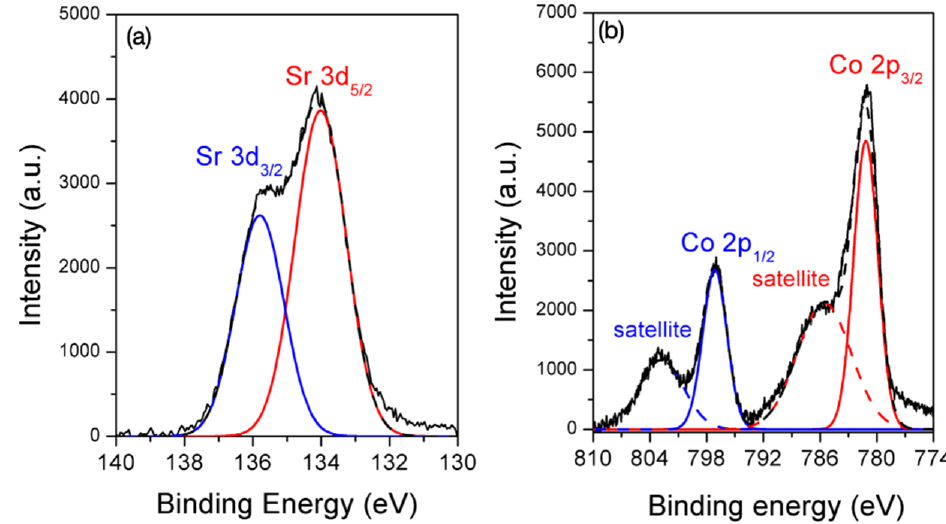
Figure 7. ( a ) Sr-3d and ( b ) Co-2p XPS spectra of post-adsorption BK3.